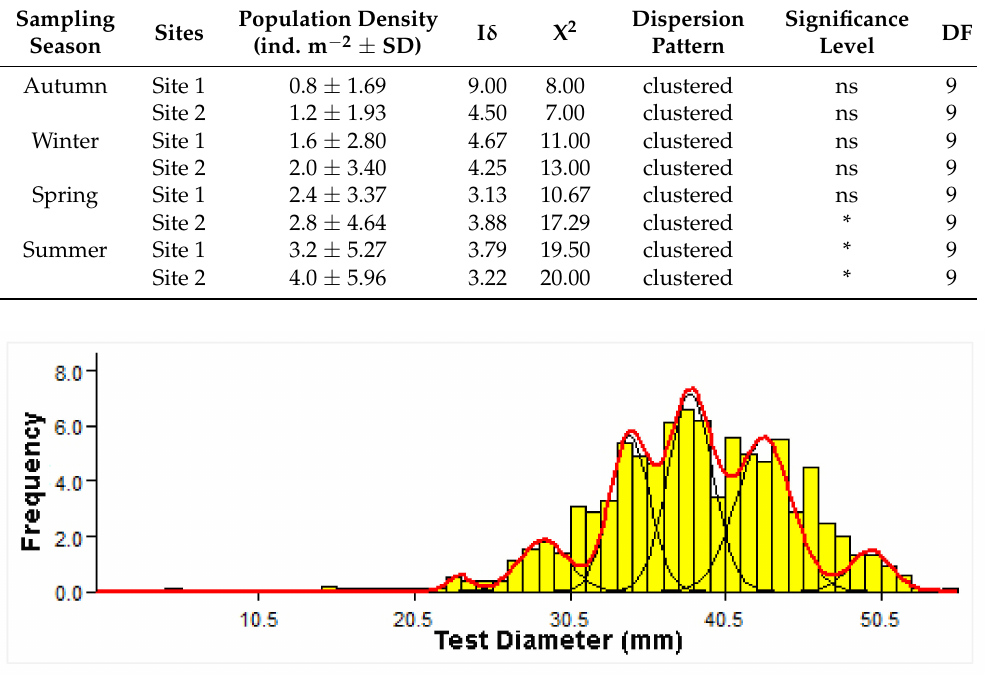
Figure 5. Population cohorts identified with Bhattacharya’s method for the total Arbacia lixula population. Table 5. Population characteristics of the age groups identified for the entire Arbacia lixula population (mean length, standard deviation, population size, separation index and population percentage at each age